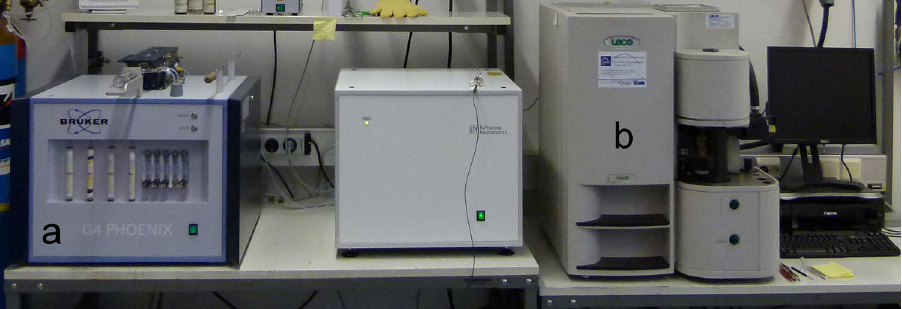
Fig. 2 The Hydrogen analys- ers used: a Bruker G4 Phoenix analyser for diffusible Hydro- gen, b LECO TCH 600 analyser for hydrogen, nitrogen and